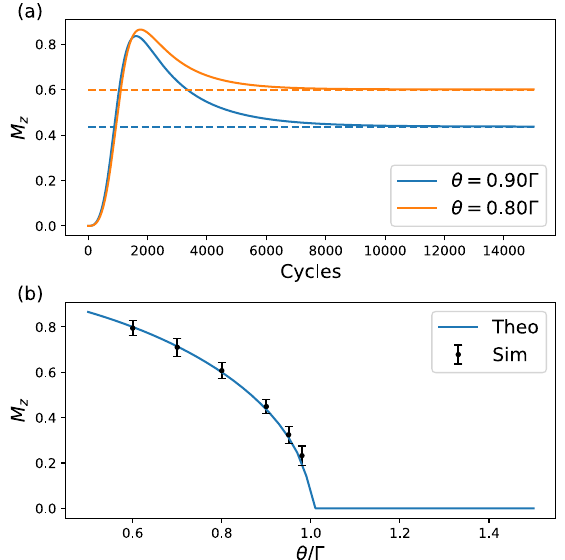
0.1 . ( a ) M Figure 3. The stationary value and phase transiton at EP at φ z approaches a stationary value when = Ŵ > θ . The solid lines are results simulated with collapse_wavefunction and cheat functions of the simulator backend. The dashed lines represents the theoretical stationary values. ( b ) shows the phase transitions of M z at EP. The n -cycle non-Hermitian circuit is repeated 500 times for a single estimation of M z , and the whole process is again repeated 20 times to get the average and the variance for each Ŵ